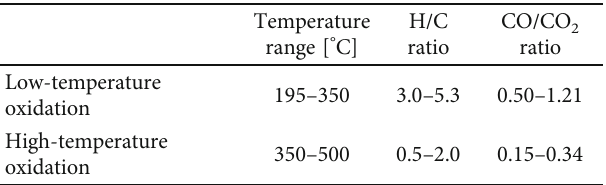
ratio ( m ) values for the fi ve 2